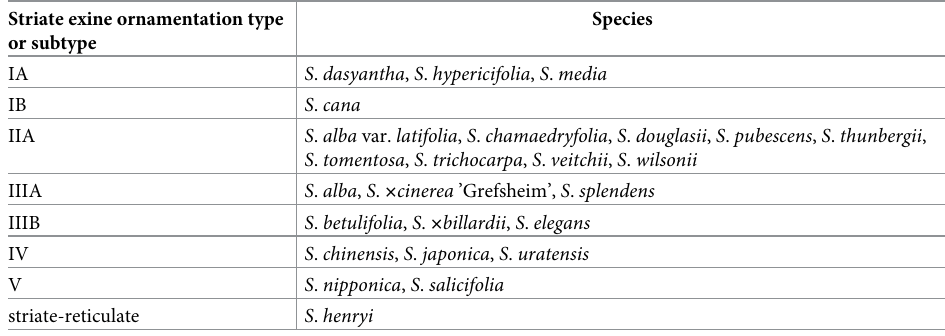
Table 6. Exine ornamentation types and subtypes of Spiraea species studied (according to the classification of Ueda and Tomita [63]). Striate exine ornamentation type or subtype